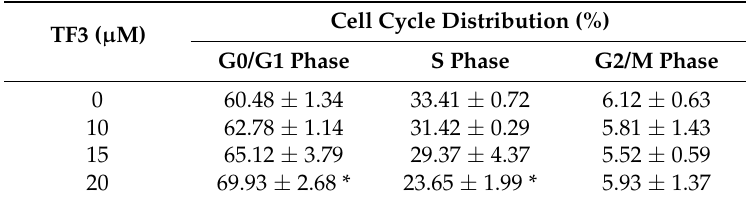
Table 1. Cell cycle distribution of TF3-treated OVCAR-3 cells.